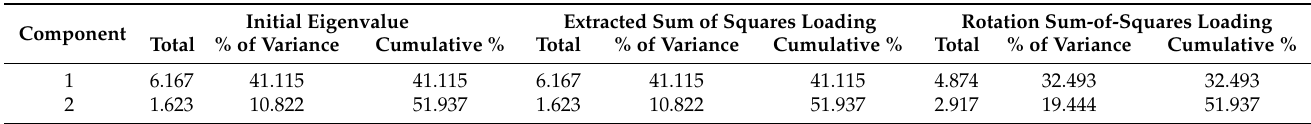
Table 3. Explained total variance for each factor.